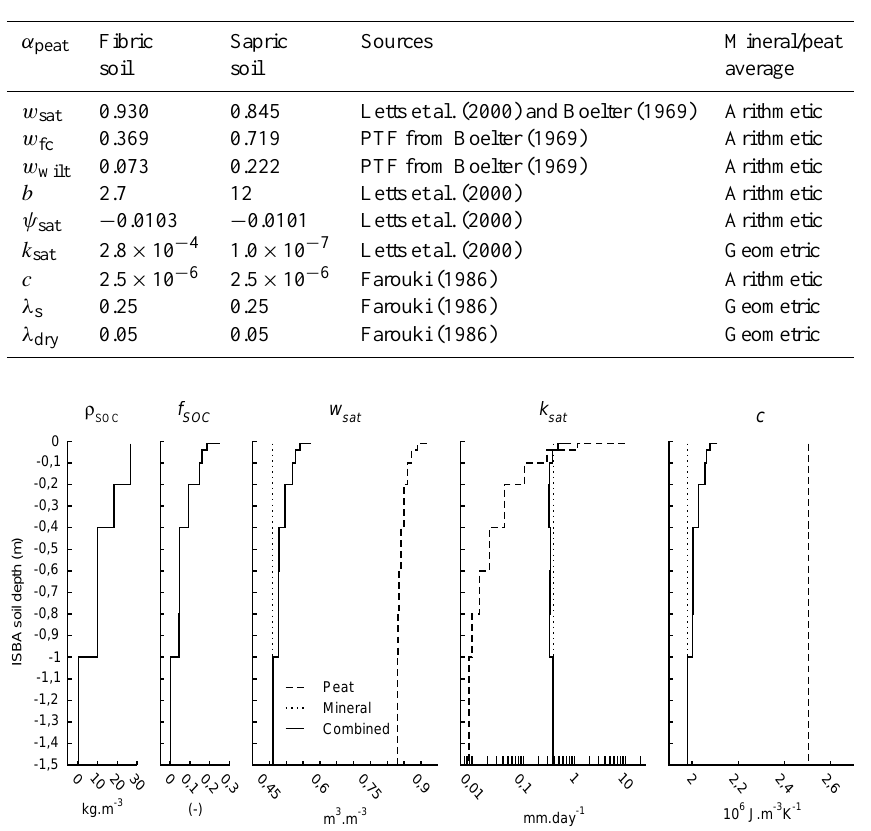
Table 1. The peat soil hydraulic and thermal parameter values used in ISBA for fibric and sapric soil. w sat (m 3 m − 3 ) is the porosity, w fc (m 3 m − 3 ) the water content at field capacity specified as matric potential at − 0.1 bar for peat soil, w wilt (m 3 m − 3 ) the water content at wilting point (matric potential of − 15 bar), b the dimensionless shape parameter of the soil water retention curve, ψ sat (m) the soil matric potential, k sat (ms − 1 ) the soil hydraulic conductivity at saturation, c (Jm − 3 K − 1 ) the soil heat capacity of organic matter, λ s (Wm − 1 K − 1 ) the thermal conductivity of soil matrix, and λ dry (Wm − 1 K − 1 ) the dry soil thermal conductivity. For pedotransfer functions of Boelter (1969), the fiber content in fibric soil is assumed to be equal to 76.8% against 21.8% in sapric soil in order to reach soil porosity values close to Letts et al. (2000). The method for averaging mineral soil properties with peat soil values using the fraction of soil that is organic is also given for each parameter.